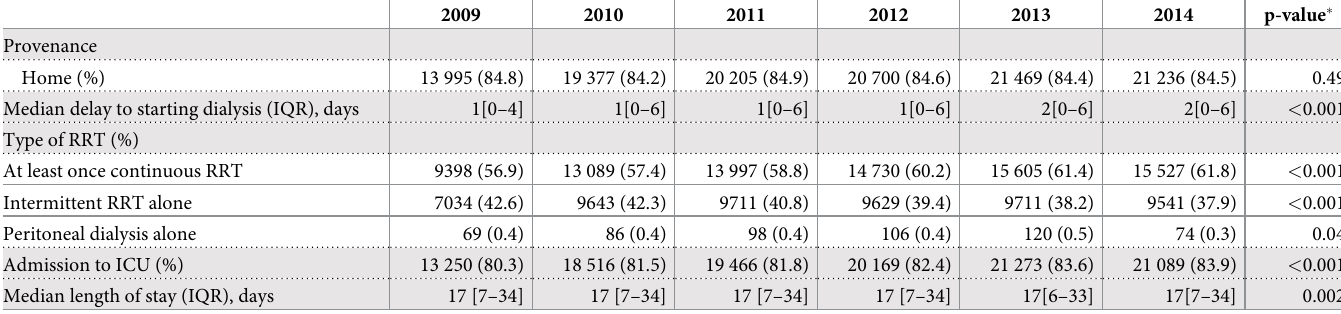
Table 2. Changing patterns in management of stays with AKI requiring dialysis between 2009 and 2014 in metropolitan